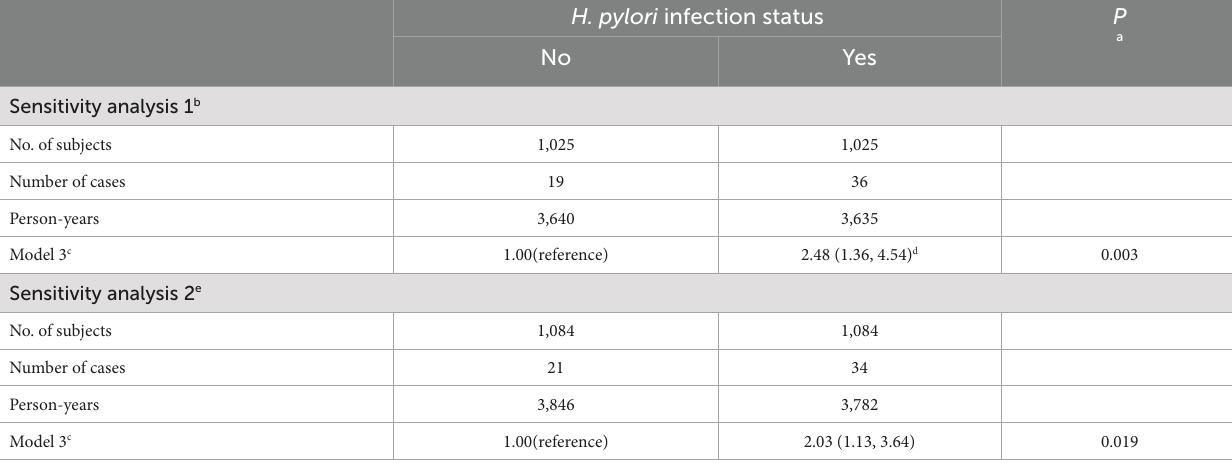
TABLE 4 Sensitivity analysis of the association between Helicobacter pylori infection status and Subclinical hyperthyroidism in